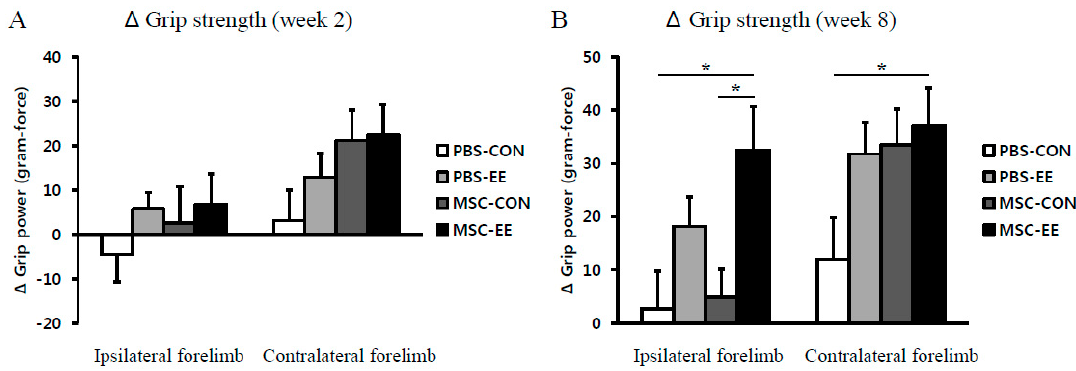
Figure 7. The combination of MSCs and EE synergistically improved grip power. Grip strength test was performed in ipsilateral ( right ) and contralateral ( left ) forelimbs two and eight weeks after treatment. ( A ) Two weeks after treatment, the MSC-EE mice expressed a tendency to exhibit enhanced motor function, but no significant differences were observed among the groups; ( B ) The MSC-EE mice were increased the grip strength in both limbs (* p < 0.05, n = 15 each). Values represent mean + SEM.